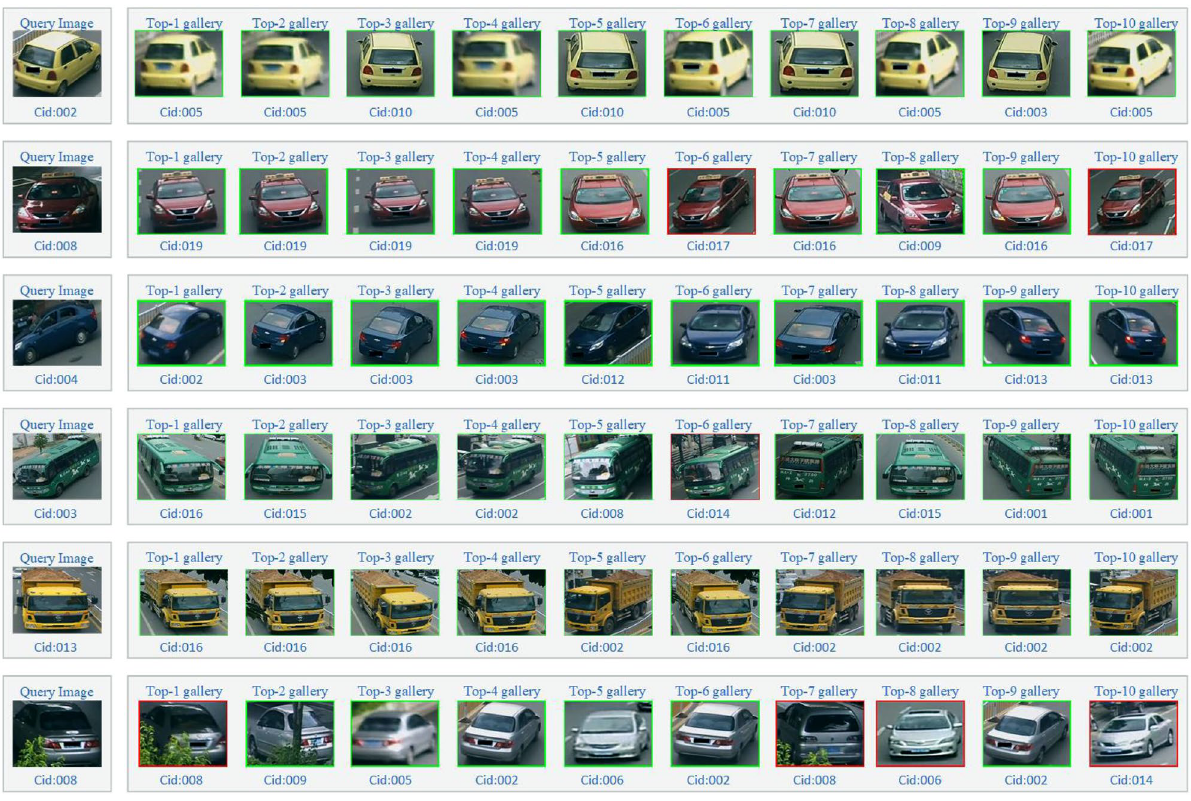
Figure 7. Visualization of model retrieval